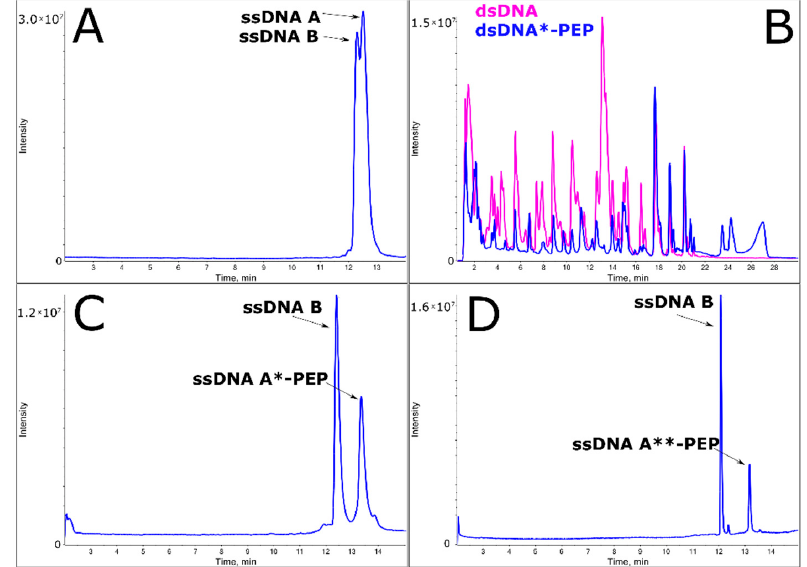
Figure 6. Liquid chromatography-mass spectrometry (LC-MS) analysis of the following biomolecules represented by Total Ion chromatogram: ( A ) dsDNA; ( B ) DNase I digestion patterns of dsDNA (pink) and dsDNA*-PEP (blue); ( C ) dsDNA*-PEP; ( D ) dsDNA**-PEP. The mobile phase A consisted of 400 mM HFIP and 15mM TEA in deionized ultrapure water and mobile phase B consisted of 200 mM HFIP, 7.5 mM TEA 50%( v ) MeOH and 50%( v ) H 2 O. The flow gradient condition was as follows: for purity check, 0–40% B at 15 min at 85 °C, 0–1 min 0% B; for footprinting analysis, 1–30 min 60% B at 50 °C.